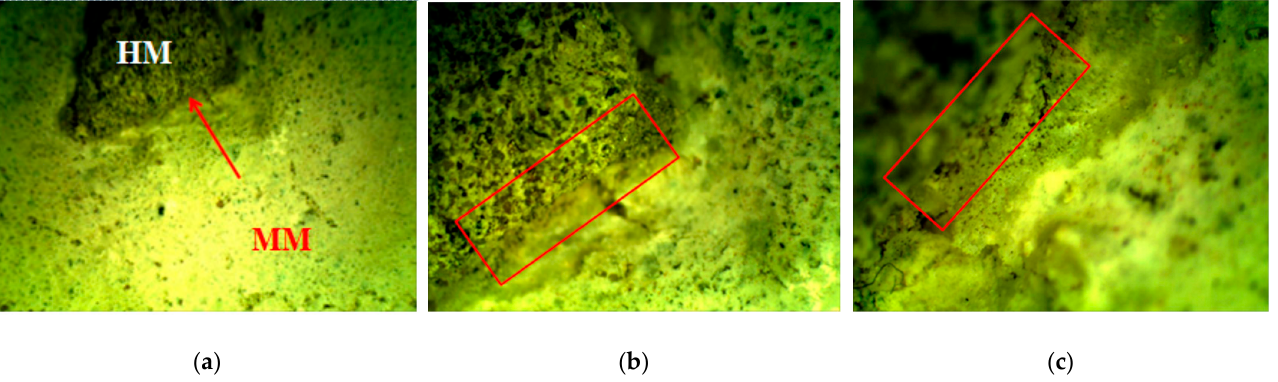
Figure 5. Stereo-optical microscopy: marked contact zone formation between original HM and